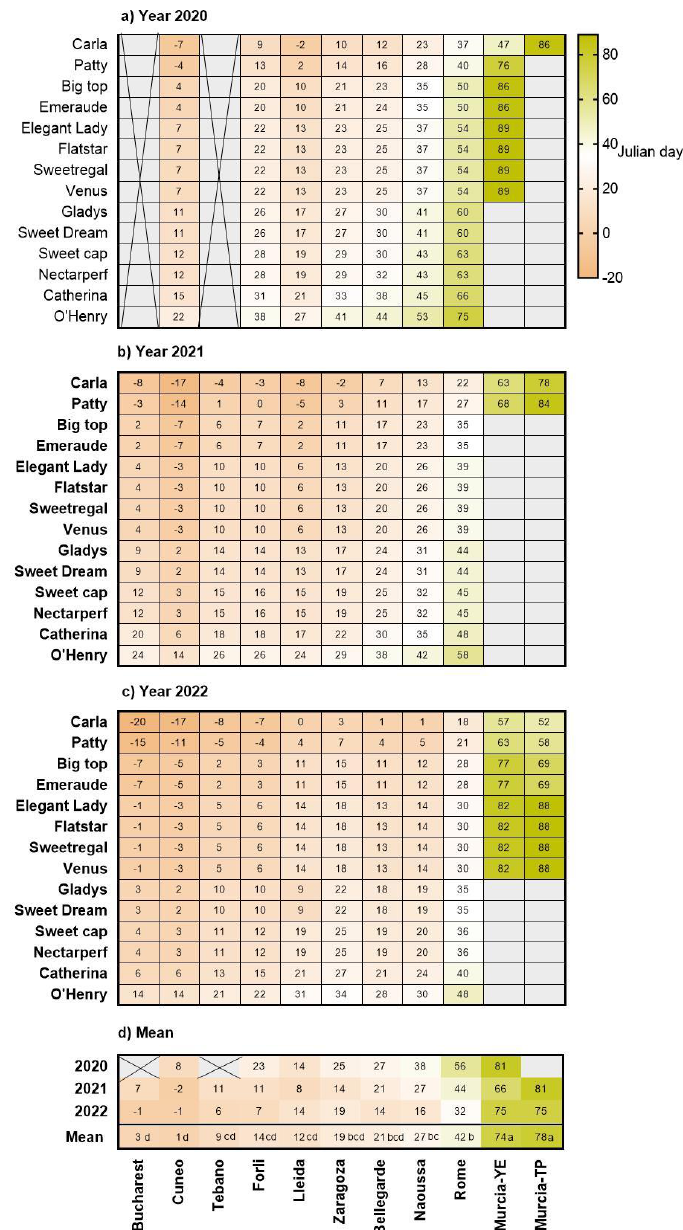
Figure 4. Heat-map showing Julian days of dormancy release, estimated as the day that chill was satisfied, for 14 peach and nectarine cultivars grown in 11 European sites, during ( a ) 2020, ( b ) 2021, ( c ) 2022, and ( d ) mean values. X = no data. Empty cells indicate that dormancy release was not achieved. YE = Yéchar; TP = Torre Pacheco. Negative values indicate days in the previous year. Means with different letters indicate significant differences among sites and cultivars, using the Tukey multiple range test.